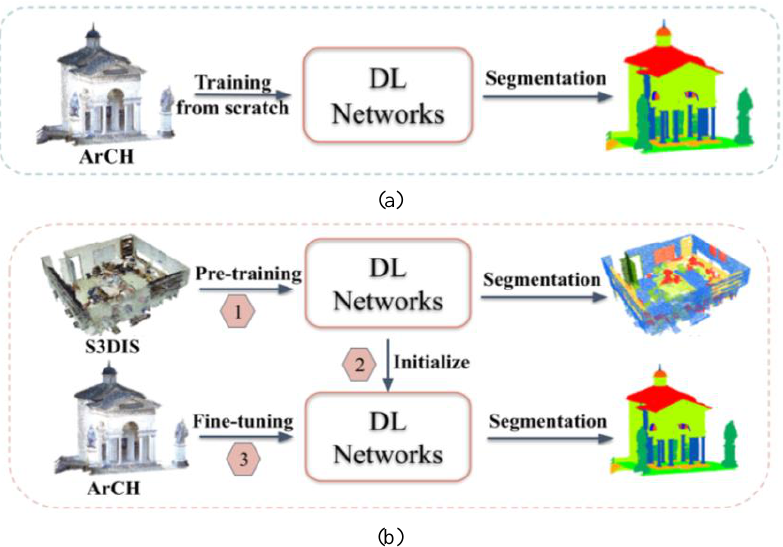
Figure 1. An illustration of the proposed pre-training method for building point cloud semantic segmentation. Our approach compares two pipelines: the top row represents the training from the scratch pipeline, while the bottom row represents the three steps of training with the proposed pre-training method pipeline: Pre-training with the Stanford 3D Indoor Scene Dataset (S3DIS – Armeni et al., 2016); using the pre-trained network to initialise the downstream task; and fine-tuning with the target Architecture